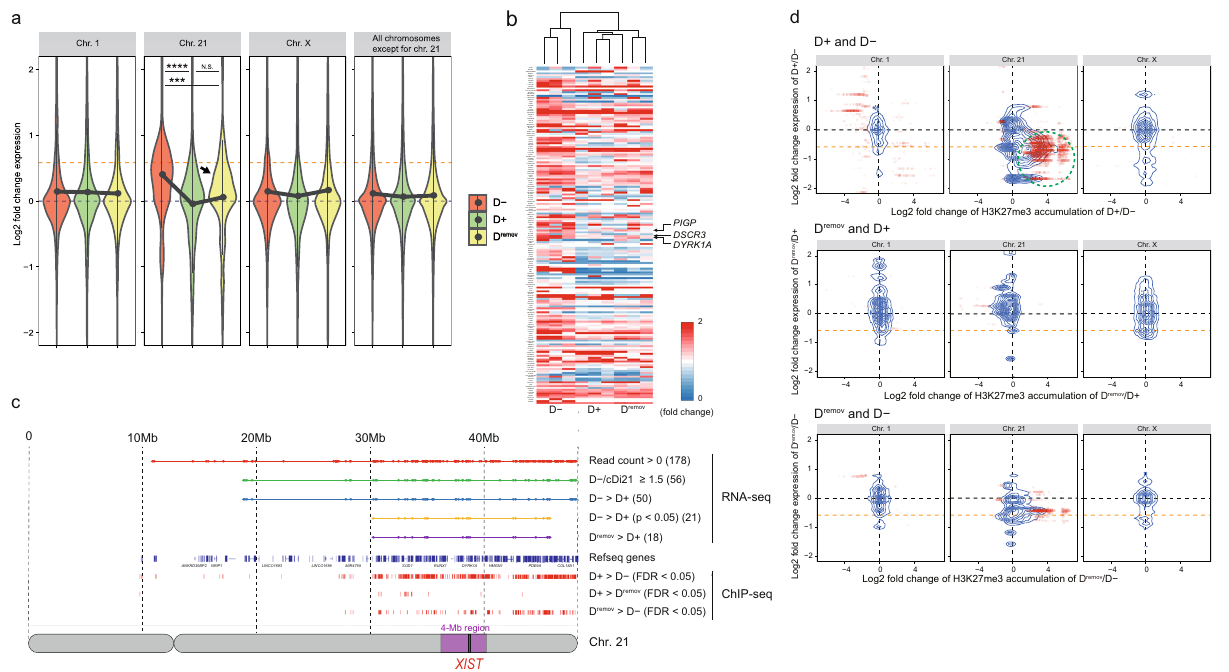
Fig. 3 Forced XIST expression causes whole-chromosome inactivation, which is overall maintained after Dox removal. a Violin plots showing relative log-transformed expression ratios of genes on each chromosome in XIST -Tri21 APC lines. Gene-expression levels (determined by RNA-seq) were normalised to those of cDi21 lines ( n = 3 per cell line). The upper orange dashed lines indicate a ratio of 1.5, whereas the lower black dashed lines indicate a ratio of 1.0. Transcription from chromosome 21 was effectively suppressed in D + cells, and inactivation was retained overall in D remov cells. A small hump was observed in chromosome 21 of a D remov cell line (black arrow). The plots show mean expression levels, with error bars indicating the SD. The data shown were analysed by the Kruskal – Wallis test with Bonferroni ’ s correction. *** P = 4.2 × 10 − 5 , **** P = 5.1 × 10 − 9 ; NS not signi fi cant ( P > 0.05). b Heatmap with a hierarchical-clustering diagram depicting the transcriptional dynamics of chromosome 21. We analysed 178 genes with positive read counts on chromosome 21. Expression levels were normalised to those of cDi21 cell lines (Supplementary Data 1 and 2). Genes are ordered according to chromosomal position. c Overview of the RNA-seq and ChIP-seq data for chromosome 21. The distribution of 178 genes with positive read counts (red plots), 56 genes with an D − /cDi21-expression ratio ≥ 1.5 (light green), 50 genes in which Dox treatment decreased expression (blue), 21 genes in which Dox treatment signi fi cantly decreased expression (Welch ’ s two-sample t -test, P < 0.05, yellow), and 18 genes in which Dox removal reverted the expression levels (purple). (Red bars) The distributions of regions with signi fi cantly higher accumulation of H3K27me3 are shown. False-discovery rates (FDRs) were calculated using the Benjamini – Hochberg method. P and FDR < 0.05 were considered to re fl ect signi fi cant differences. d Integrated analysis of the ChIP-seq and RNA-seq data. H3K27me3 accumulation within each gene body and 2 kb upstream of the transcription start site were analysed. The density of all paired points is shown with a blue contour line. Genes with a signi fi cant difference in H3K27me3 accumulation between two lines are indicated (red points). The green dashed ellipse emphasises the distribution of inactivated genes with increased H3K27me3 accumulation after Dox treatment. The orange dashed line indicates a two-thirds decrease in gene